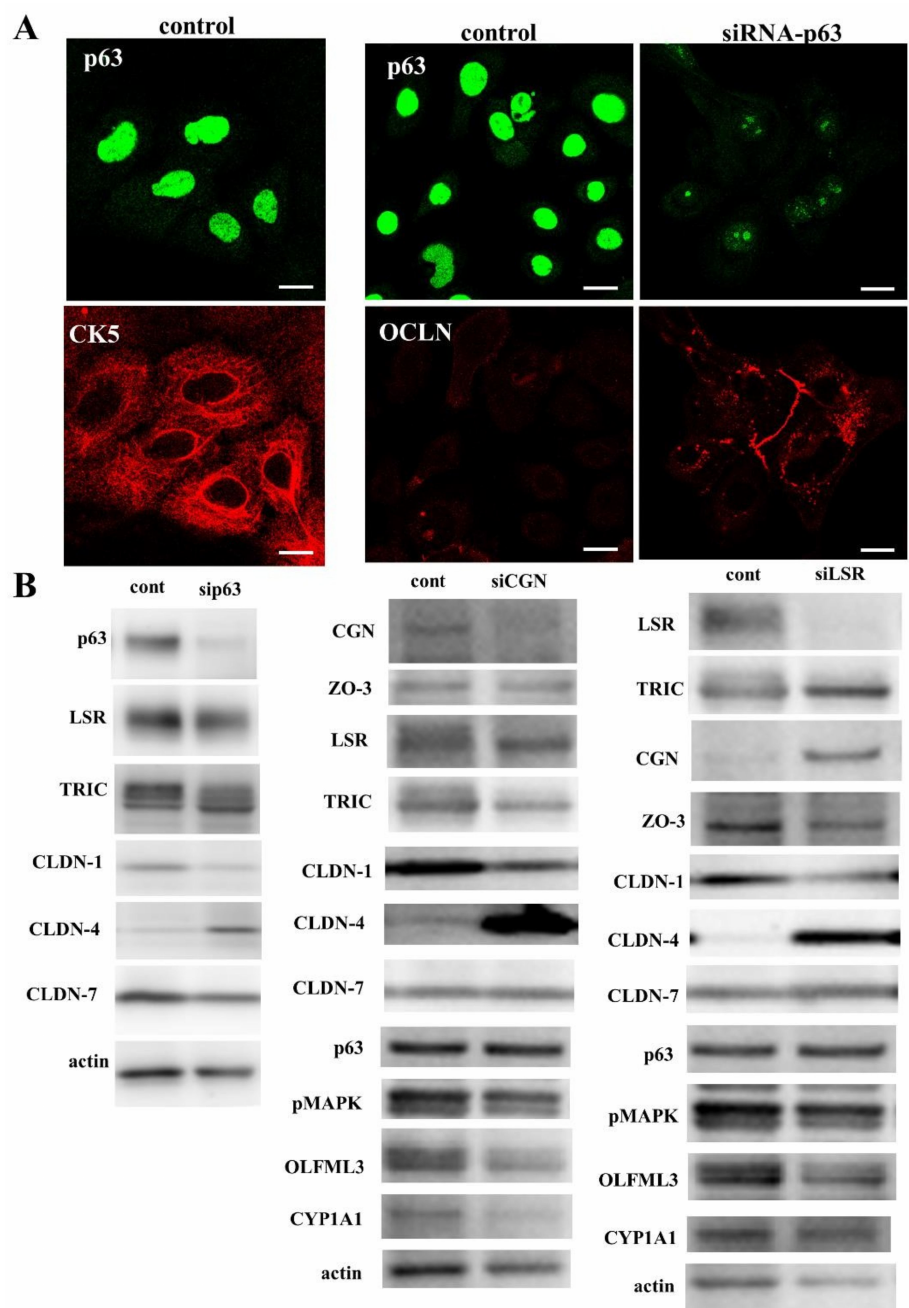
Figure 6. ( A ) Immunocytochemical staining for p63, CK5, and OCLN in cultured normal human salivary gland duct epithelial (HSDE) cells transfected with or without siRNA-p63. Scale bar: 10 µ M. ( B ) Western blotting for p63, CGN, ZO-3, angulin-1/LSR, TRIC, CLDN-1, CLDN-4, CLDN-7, pMAPK, OLFML3, CY1A1, and actin in A253 cells transfected with siRNA-p63, CGN or